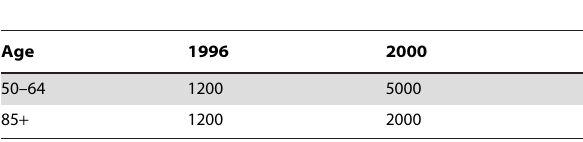
Table 1. The rate of colonoscopies per 100,000 people in the population, estimated by the National Survey of Ambulatory